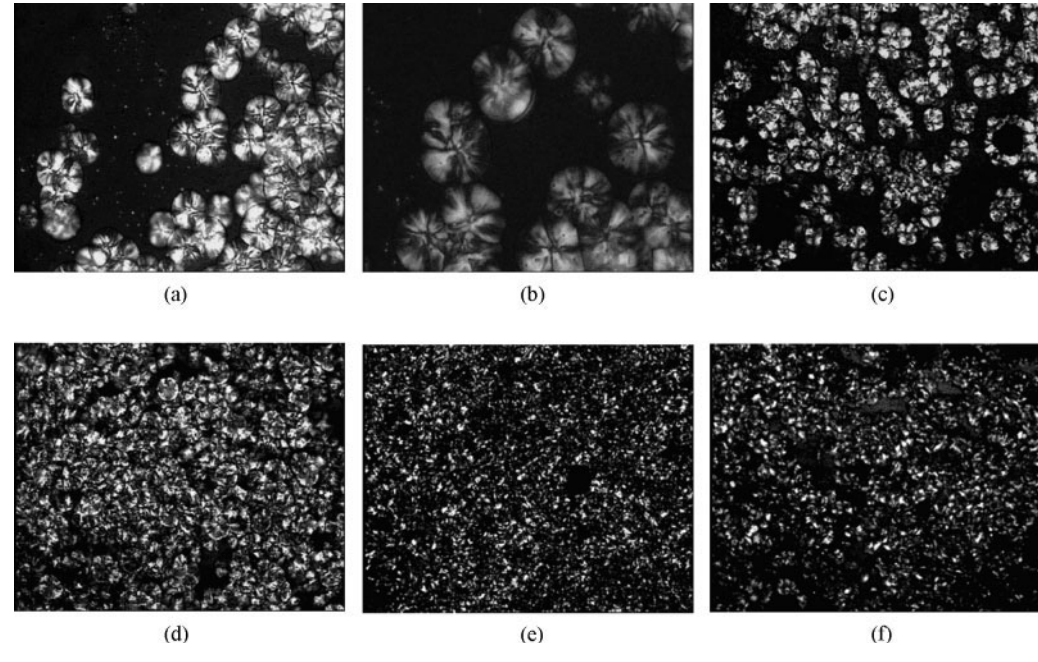
Figure 39. Crystalline morphology of (a) PP, (c) PP/0.5 wt % raw MWCNTs, (d) PP/0.5 wt % 3-MPTS functionalized MWCNTs, (e) PP/1 wt % raw MWCNTs, and (f) PP/1 wt % 3-MPTS functionalized MWCNTs by POM (3200 magnification); (b) PP by POM (3400 magnification). Reproduced with permission from ref. [90].